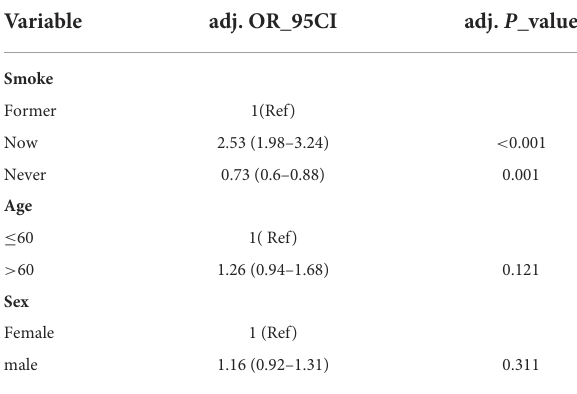
TABLE 4 The actual effect of smoking, age and gender.